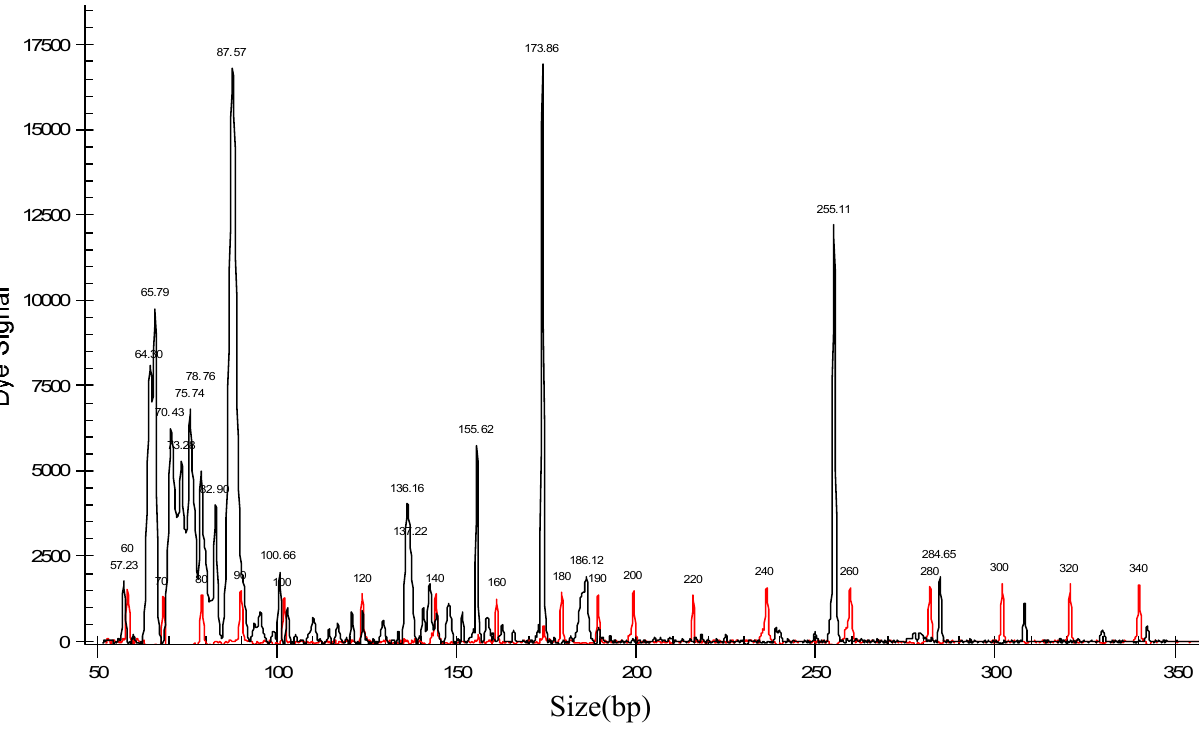
Figure 1. Electropherogram of a typical sample of J. curcas from Chiapas obtained by capillary electrophoresis. The marker of molecular size, 400 bp labeled with the fluorogenic D1WellRed ® , is showed in red. PCR products were resolved in a CEQ8000 ® (Beckman Coulter ® )